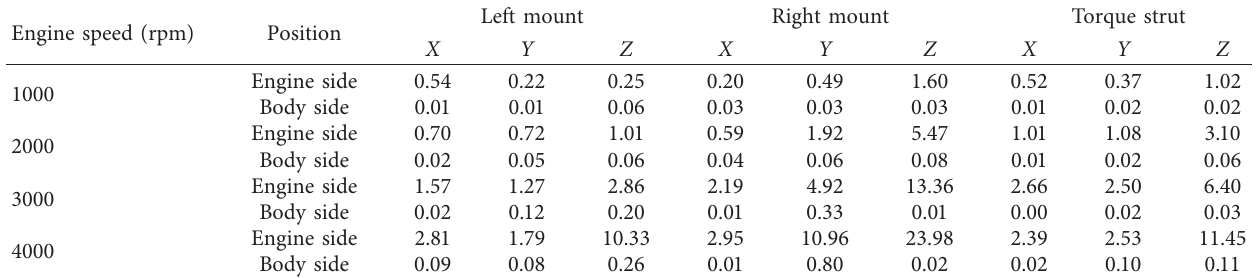
Table 4: Second-order acceleration amplitude of each mount at the body side and at the engine side under steady rotational speed (m/s 2 ). Engine speed (rpm)